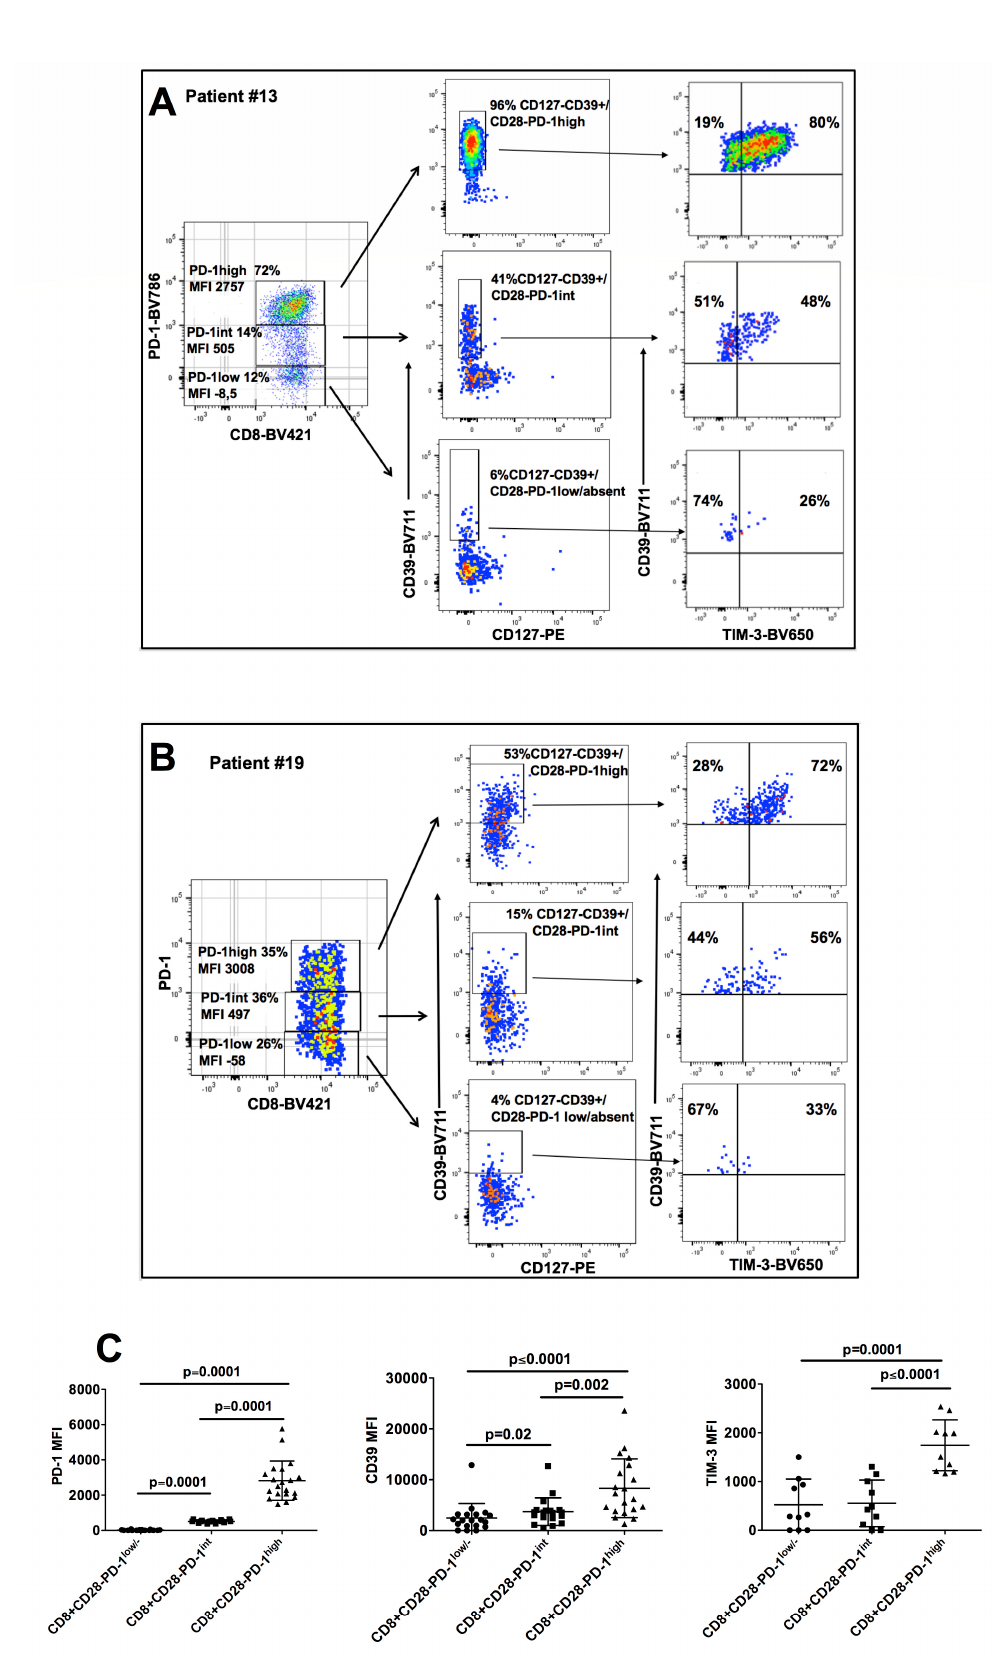
Figure 2. Phenotypic characterization of tumor infiltrating CD8+CD28 − T cells based on the levels of PD-1 expression. A and B . CD28 − T cells were gated and tumor infiltrating CD8+CD28 − T cells from representative patients #13 ( A ) and #19 ( B ) were divided in three subpopulations (CD8+CD28 − PD-1 hi , CD8+CD28 − PD1 int and CD8+CD28 − PD-1 lo/ − ,